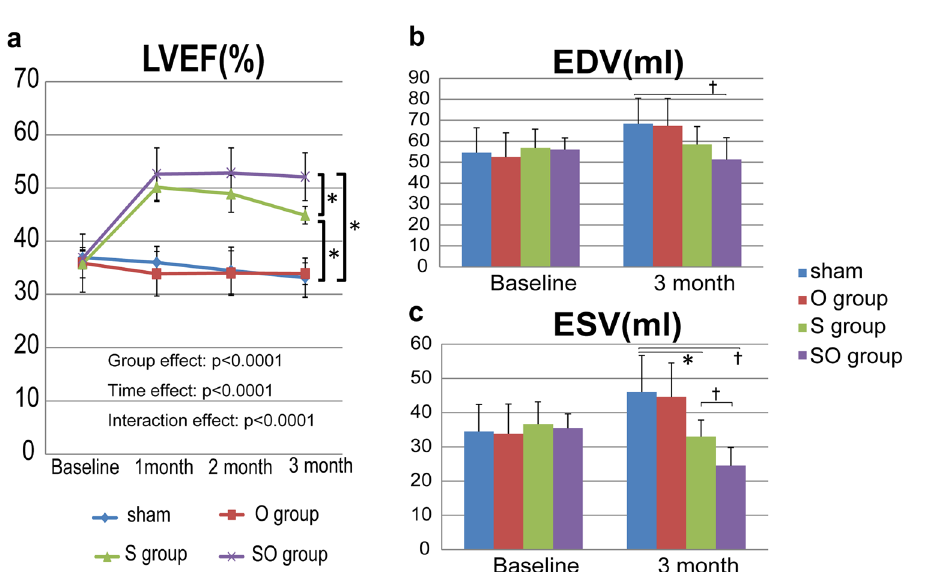
Figure 3. CMR analysis for global cardiac functions: LVEF in a, LVEDV in b, and LVESV in c. ( a ) LVEF at 3 months was significantly greater in the SO group than in the S group. ( b ) LVEDV at 3 months in combination group showed significantly smaller than those in the sham group. ( c ) LVESV at 3 month in the S and SO group showed significantly smaller than that in the sham group. LVESV at 3 months were significantly smaller in the SO group than in the S group. † p < 0.05, * p <